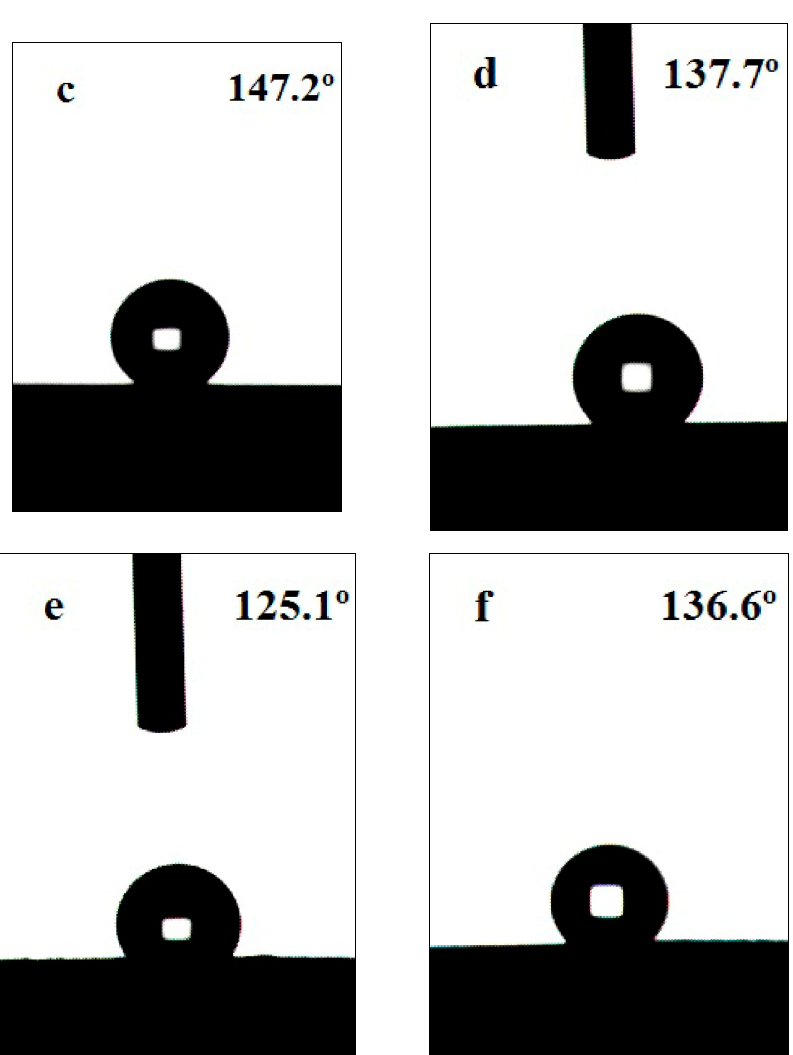
Figure 1. Optical images of water droplets on the surfaces: ( a ) untreated; ( b ) etched by10.2 wt% HCl for 42 h; ( c ) etched by 10.1 wt% H 2 SO 4 for 42 h; ( d ) etched by 10.0 wt% H 3 PO 4 for 56 h; ( e ) etched by 10.1 wt% HNO 3 for 56 h; and ( f ) etched by 40.0 wt% HF for 28 h.